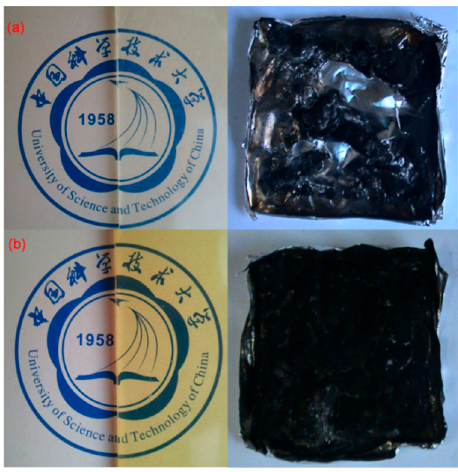
Figure 8. Photo images of samples before and after the cone calorimetry test: ( a ) BADPS0, ( b ) BADPS20.